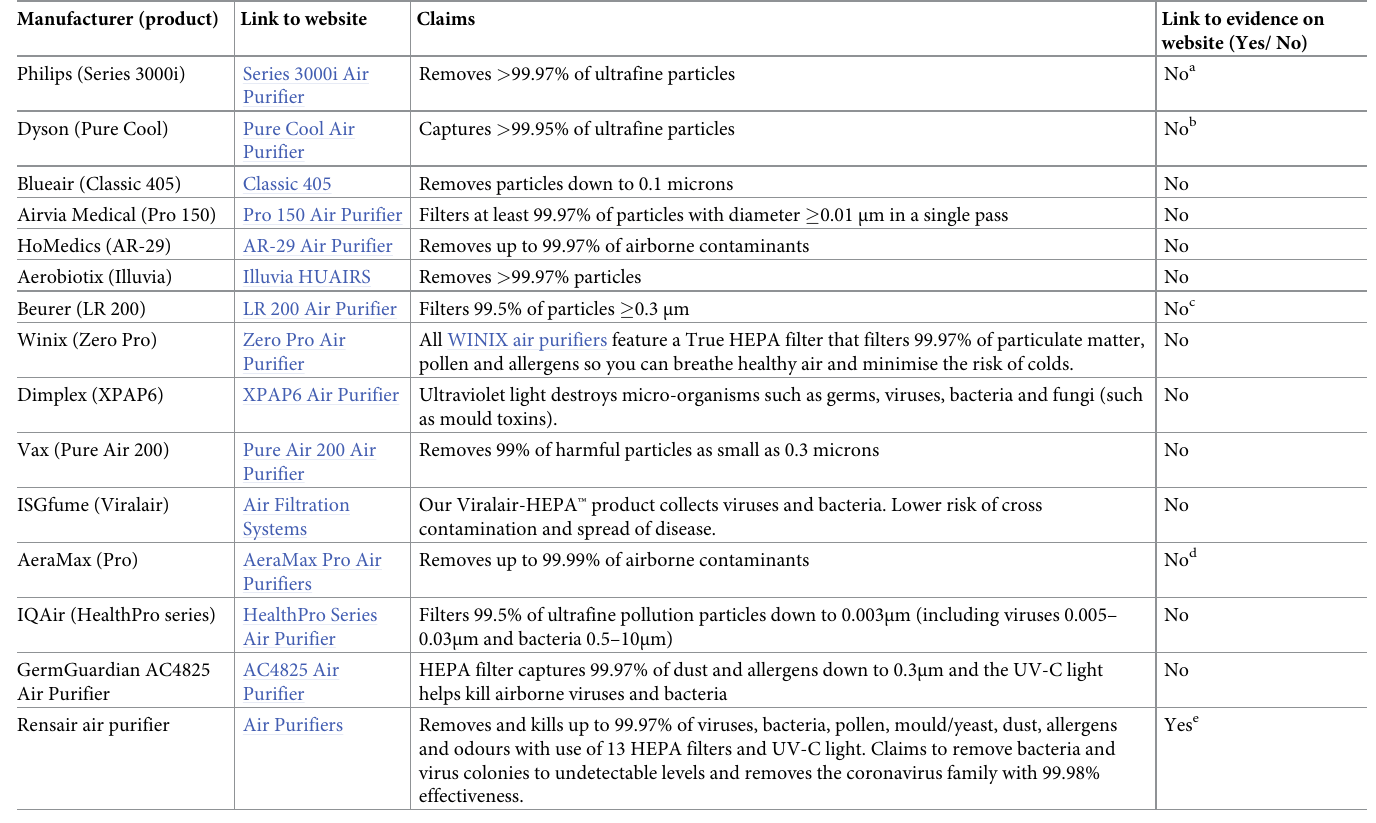
Table 1. Air filter manufacturer websites and whether the claims made on the website are corroborated with detailed evidence. Manufacturer (product) Link to